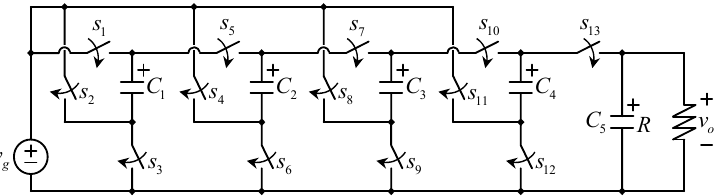
Figure 15. The MMCC Converter topology.